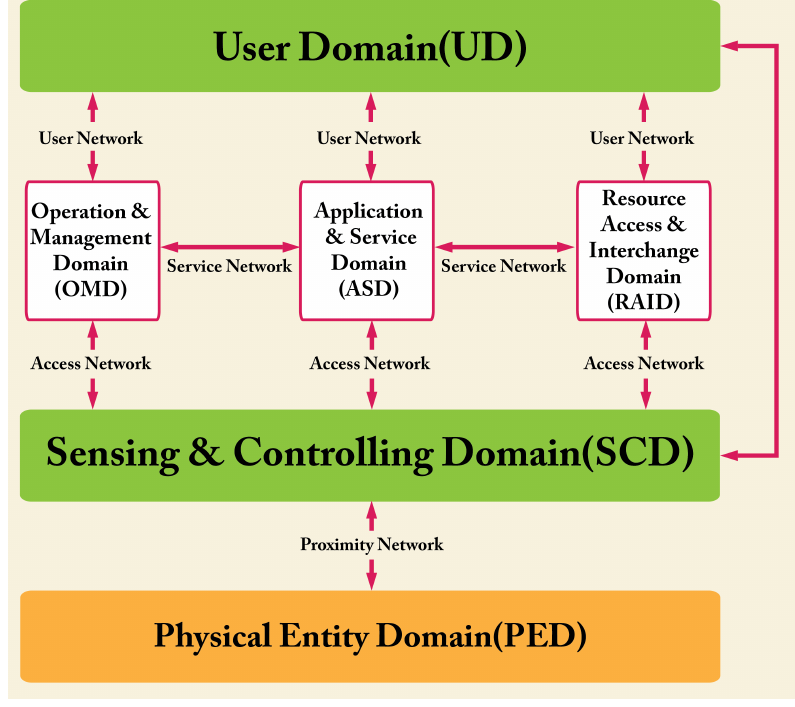
Figure 7. The domain-based IoT